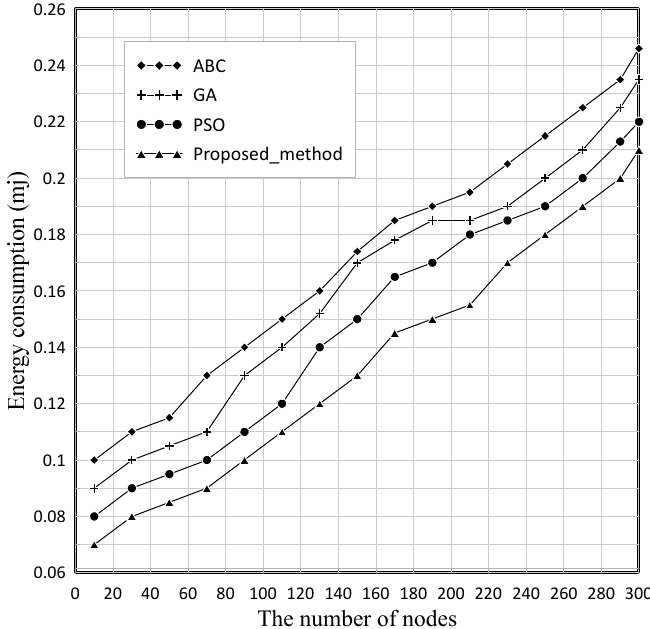
Figure 12. Comparison of ABC, GA, PSO, and the proposed method in energy consumption. Delay time